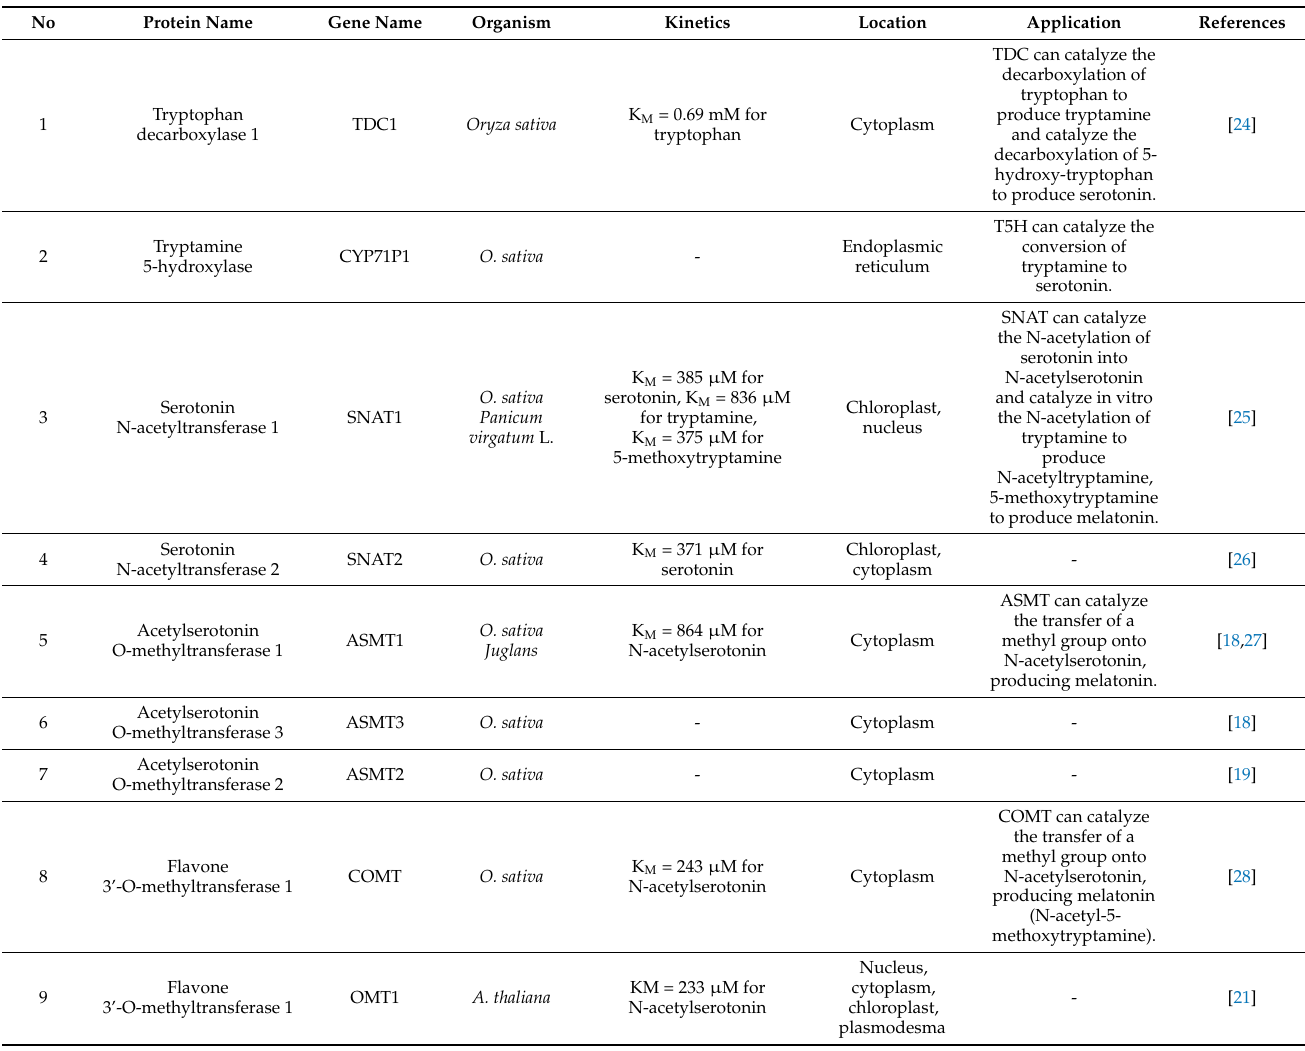
Table 1. The key protein in endogenous melatonin synthesis pathway of Arabidopsis and